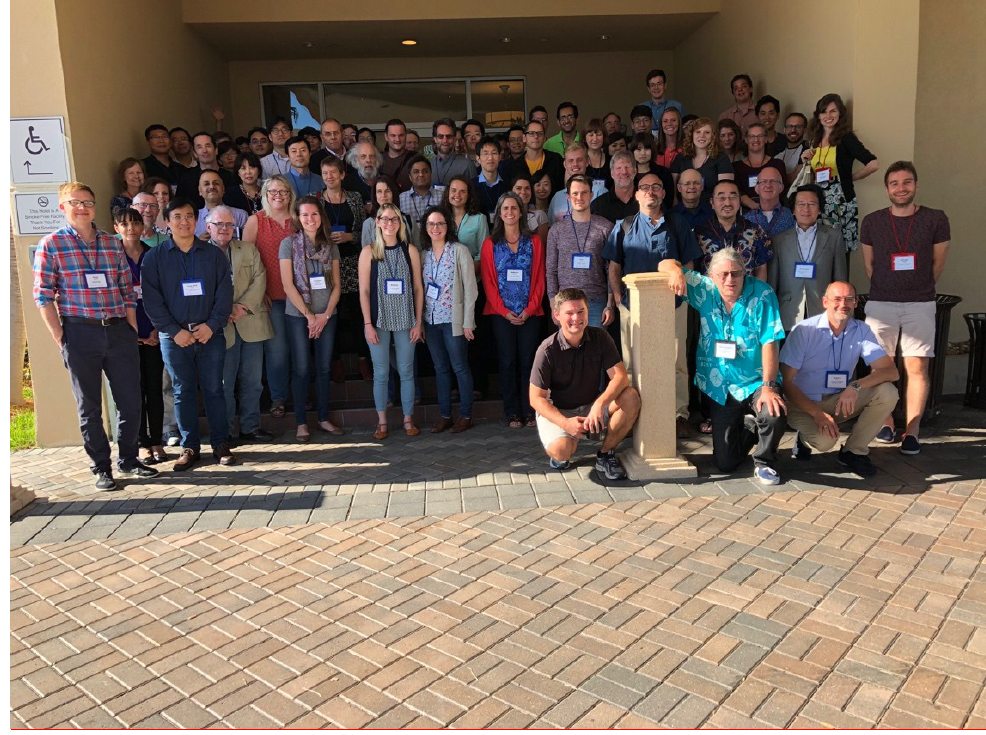
Figure 2. Group photograph of the participants at the Clearwater AARS meeting.